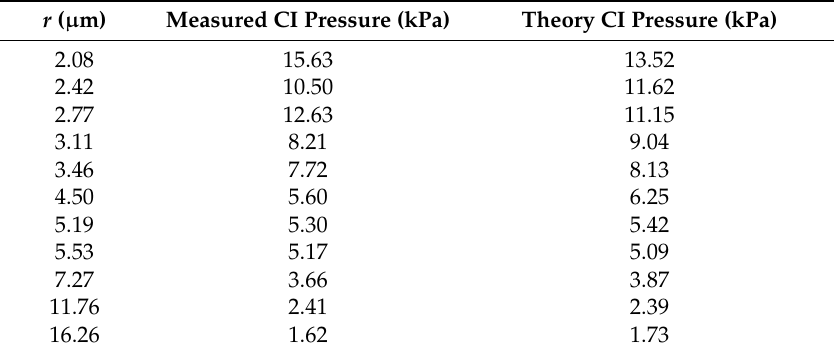
Table 1. The measured critical injection (CI) pressure versus r , and the theoretical CI pressure versus r , according to Equation